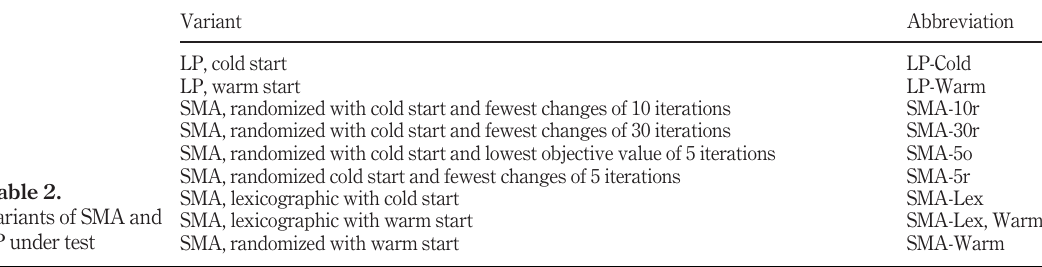
Table 2. Variants of SMA